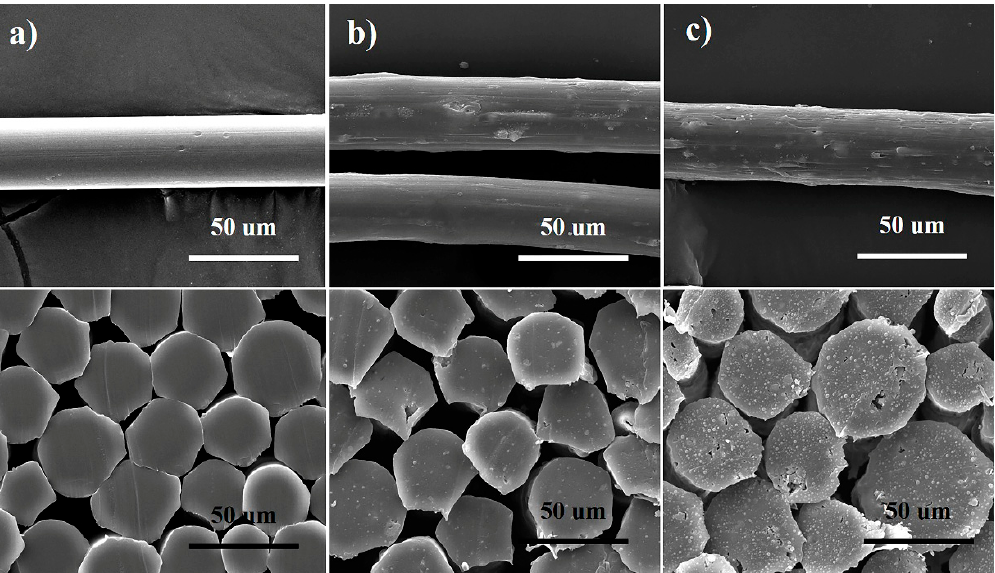
Figure 6. SEM images of the surface topography and cross section for mPP fiber ( a ), mPP-IFR-10 fiber ( b ) and mPP-IFR-20 fiber ( c ).